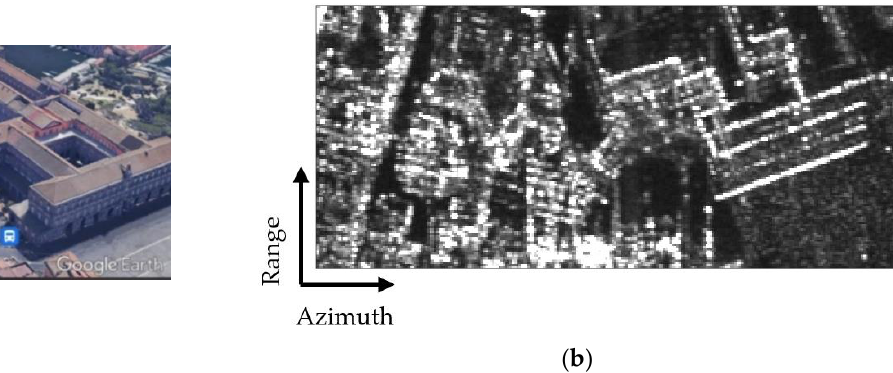
Figure 3. Images of Galleria Umberto I, Naples, Italy. ( a ) Optical image and ( b ) SAR image (Copyright DLR 2012 – 2014).